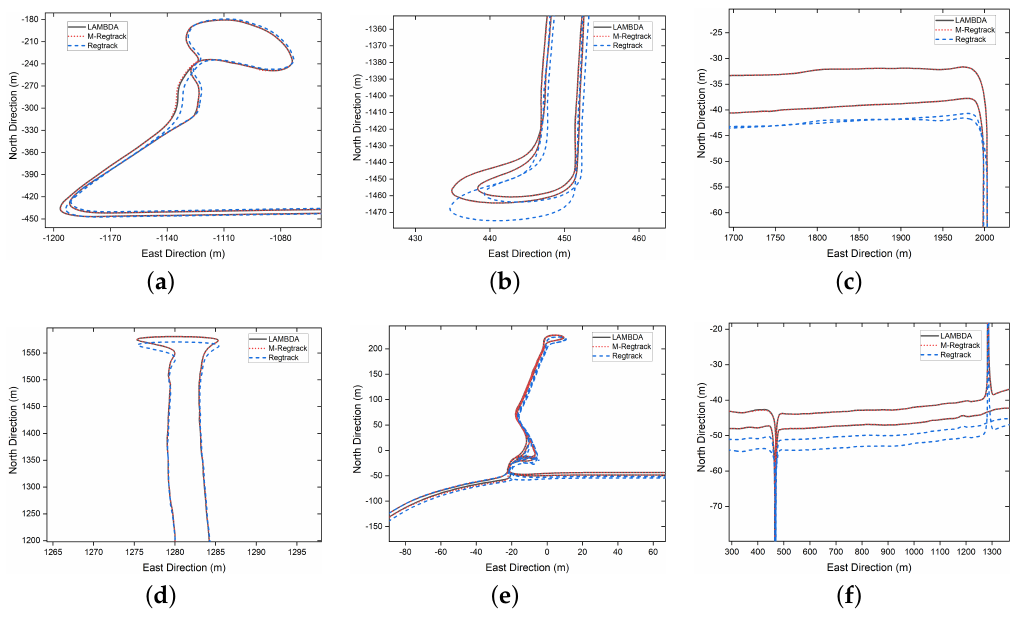
Figure 9. Enlarged part of the trajectory tracking result, where ( a – f ) represents the enlarged part of Figure